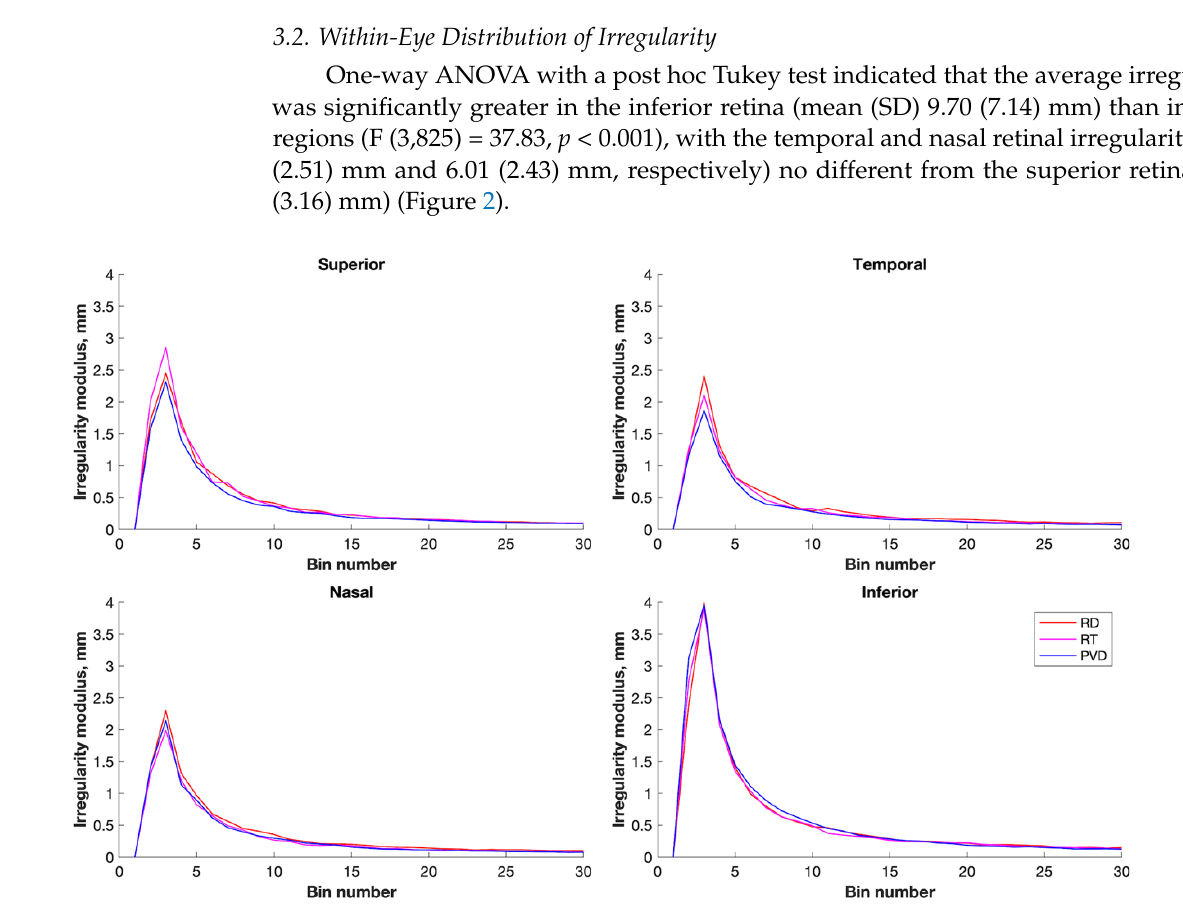
Figure 2. Regional irregularity, swept-source OCT. Average irregularity (presented here in frequency domain partitions (bins) for superior, temporal, inferior, and nasal retina) was greatest in the inferior retina for all diagnostic groups. PVD eyes (blue), retinal detachment eyes (red), and retinal tear eyes (pink). Irregularity units are mm 2 per mm of retina, hence